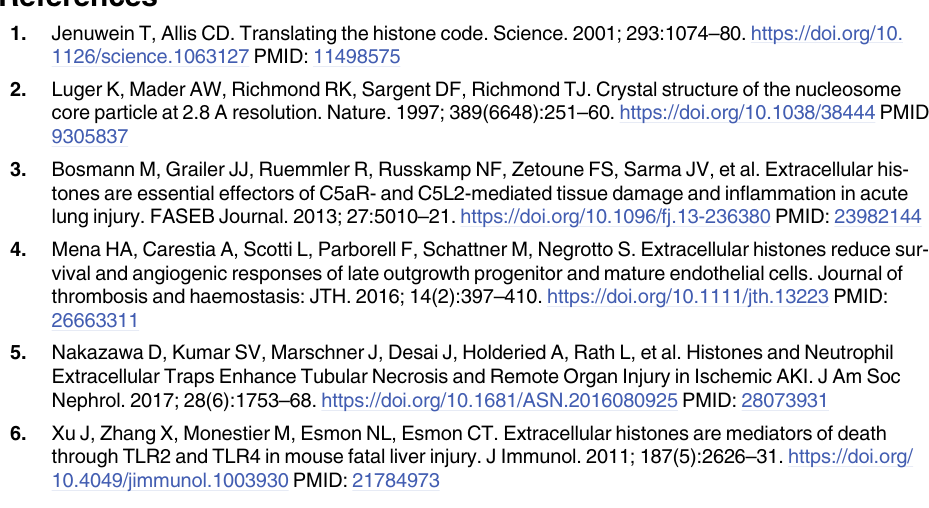
S1 Table. Friedman and Mann-Whitney tests for differences between type of perfusion group per time